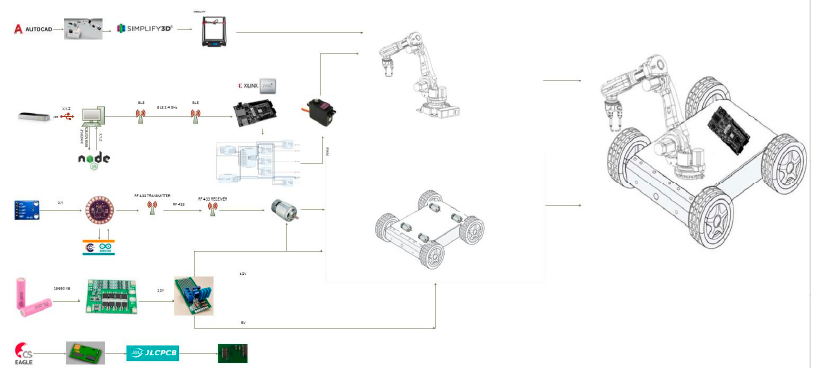
Figure 2. System Overview.